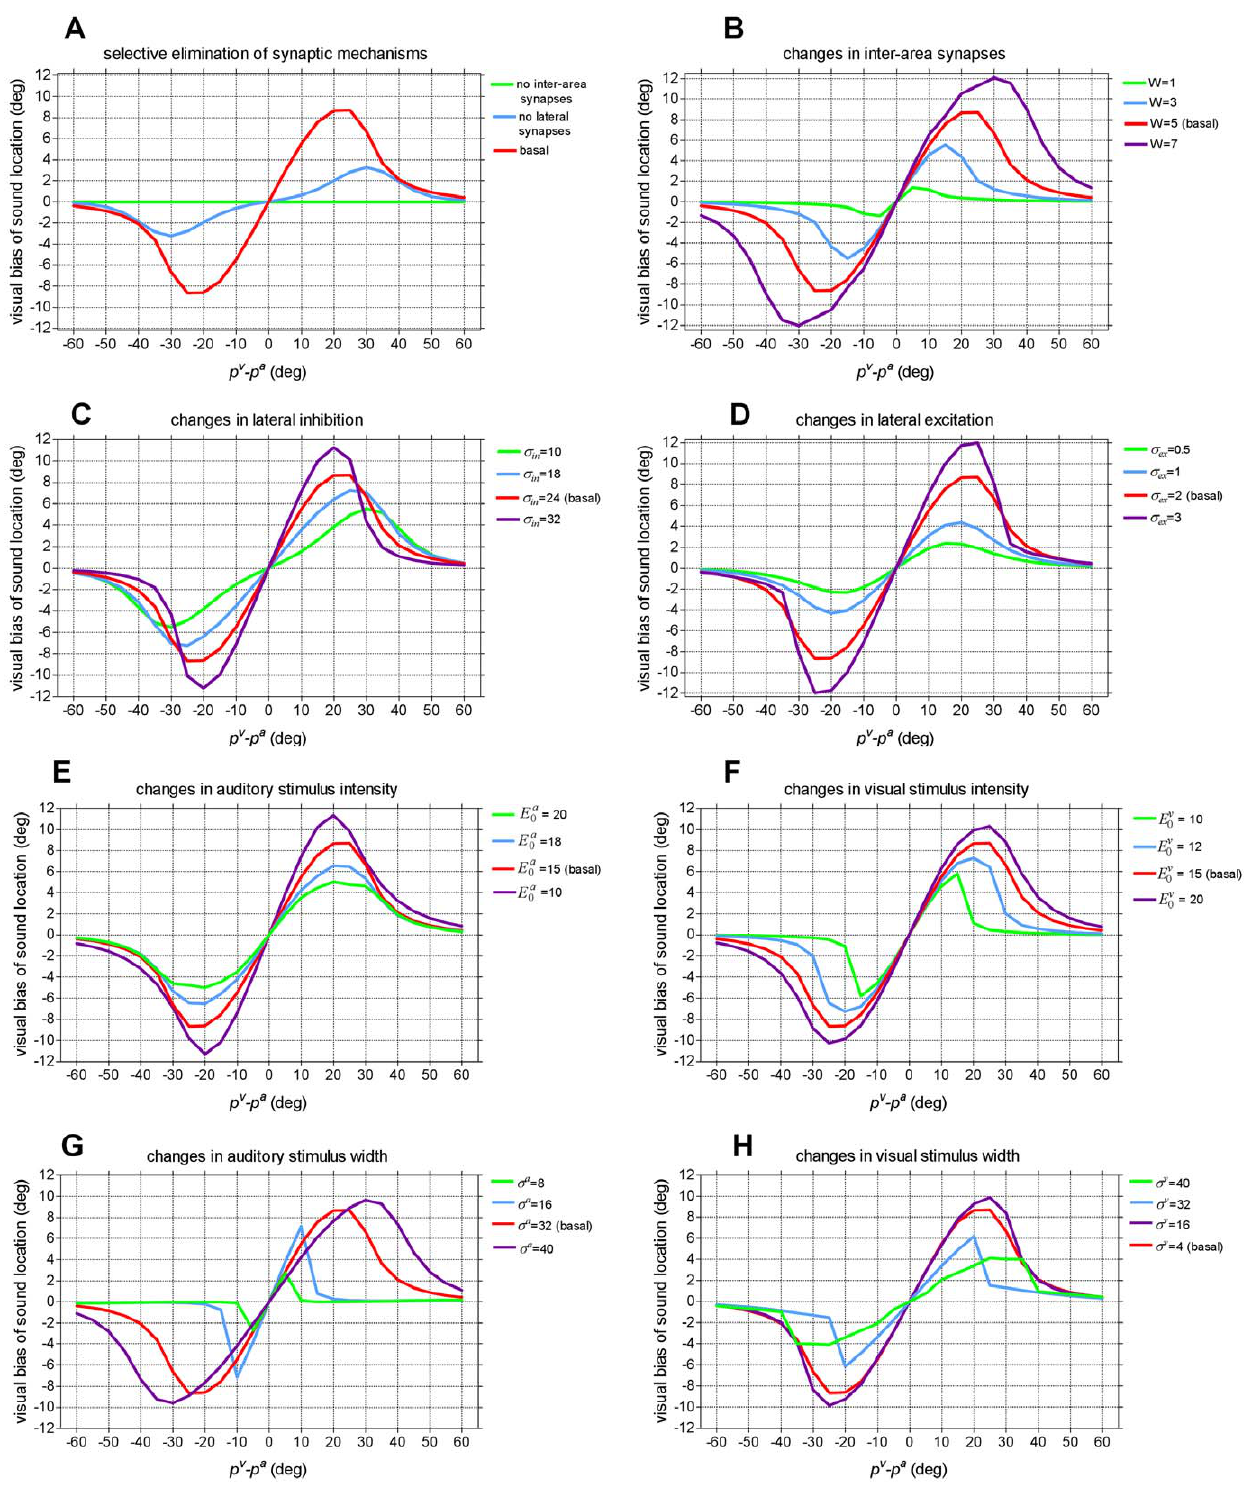
Figure 5. Results of sensitivity analysis. Visual bias of sound location as a function of the visual-auditory angular separation (same simulation as Fig. 4), obtained using different values for the parameters characterizing synaptic connections (panels A, B, C, D) and external stimuli (panels E, F, G, H). One parameter at a time was changed, by maintaining the others at their basal value. ( A ) Selective elimination of synaptic mechanisms (elimination of inter-area synapses, elimination of lateral synapses). ( B ) Changes in the weight of inter-area connections ( W ). ( C ) Changes in the extension of lateral inhibitory synapses ( s in ). ( D ) Changes in the extension of lateral excitatory synapses ( s ex ). It is worth noting that here the balance between lateral excitation and inhibition was varied by modifying the width of lateral synapses. Similar results can be obtained by acting on the strength of lateral synapses (parameters L ex0 , L in0 ). ( E ) Changes in the strength of the auditory stimulus ( E a ). ( G ) Changes in the width of the auditory stimulus ( s a ). ( H ) Changes in the width of the visual stimulus ( s v ). stimulus ( E v 0 doi:10.1371/journal.pone.0042503.g005 PLoS ONE |